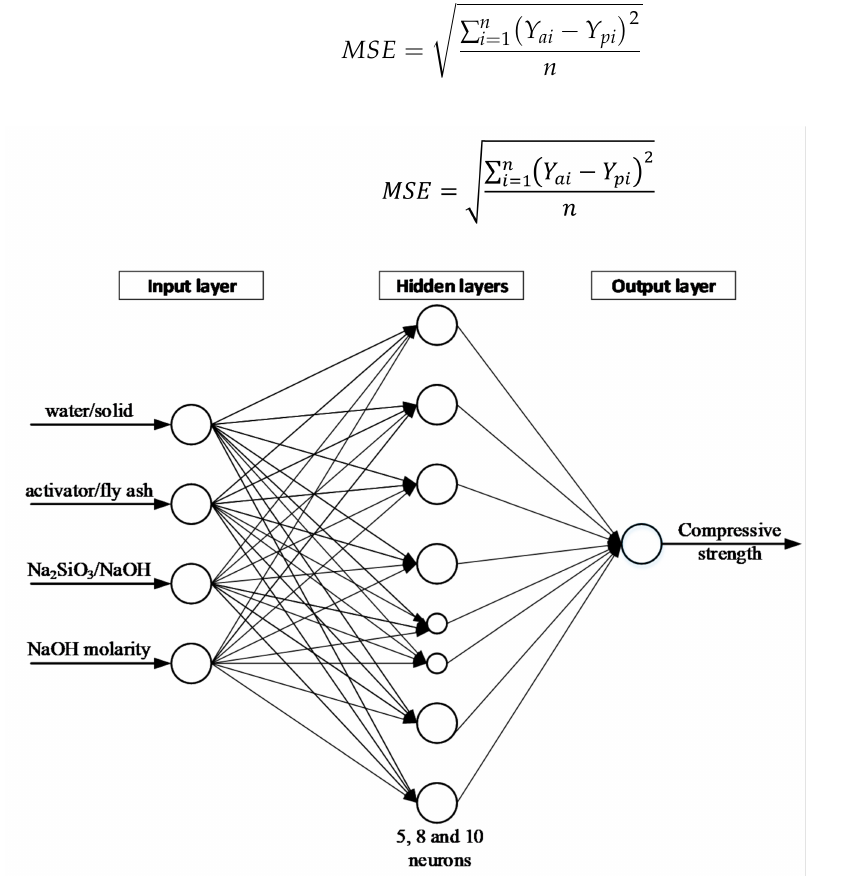
Figure 1. Schematic diagram of artificial neural network (ANN)